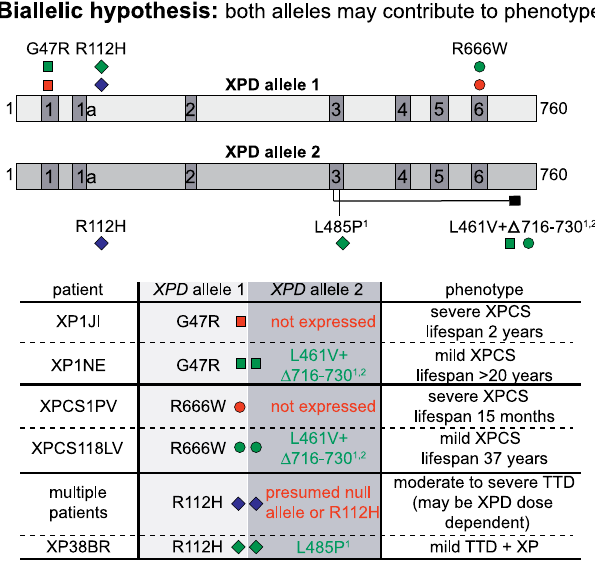
Figure 5. Genotype–Phenotype Relationships in XPD